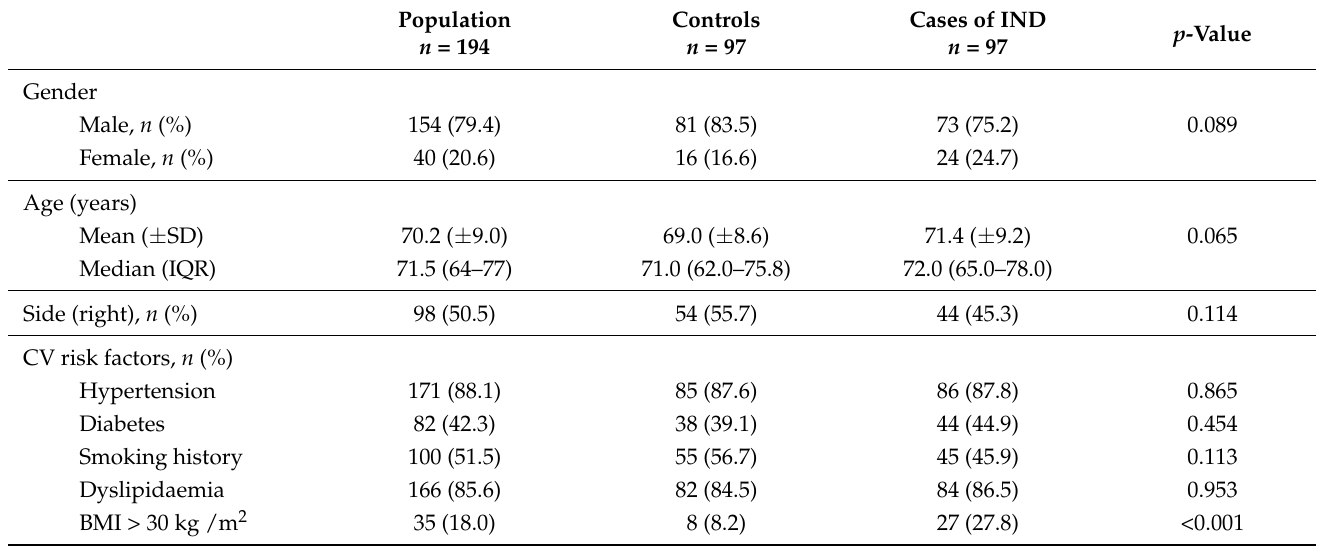
Table 1. General patient’s characteristics and preoperative